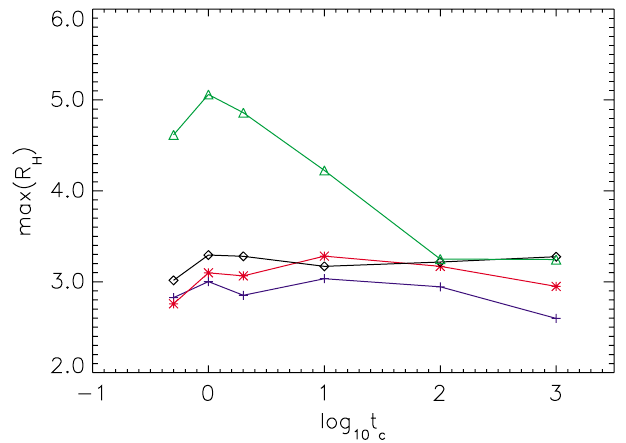
FIG. 5. (Color) Percentage P (cid:6) r > R (cid:7) vs R of test particles ( N (cid:2) (cid:7) versus the FIG. 4. (Color) Maximum halo amplitude max (cid:6) R 10 6 ) lying outside radius R at the end of the simulation ( t (cid:2) H computed for N (cid:2) 10 4 logarithm of the autocorrelation time t 512 ) for various noise strengths with (a) (cid:13) c (cid:2) 0 : 05 and (cid:13) (cid:2) 0 . Blue curve with (cid:2) 0 : 1 . Fixed parameters are t test particles with (cid:13) (b) (cid:13) 1 2 1 crosses: hj (cid:22)! ji (cid:2) 0 : 002 ; red curve with asterisks: hj (cid:22)! ji (cid:2) curve with crosses: hj (cid:22)! ji (cid:2) 0 ; red curve with asterisks: hj (cid:22)! ji (cid:2) 0 : 001 ; black curve with diamonds: hj (cid:22)! ji (cid:2) 0 : 01 ; 0 : 01 ; black curve with diamonds: hj (cid:22)! ji (cid:2) 0 : 03 ; green curve with triangles: hj (cid:22)! ji (cid:2) 0 : 1 . green curve with triangles: hj (cid:22)! ji (cid:2) 0 : 1